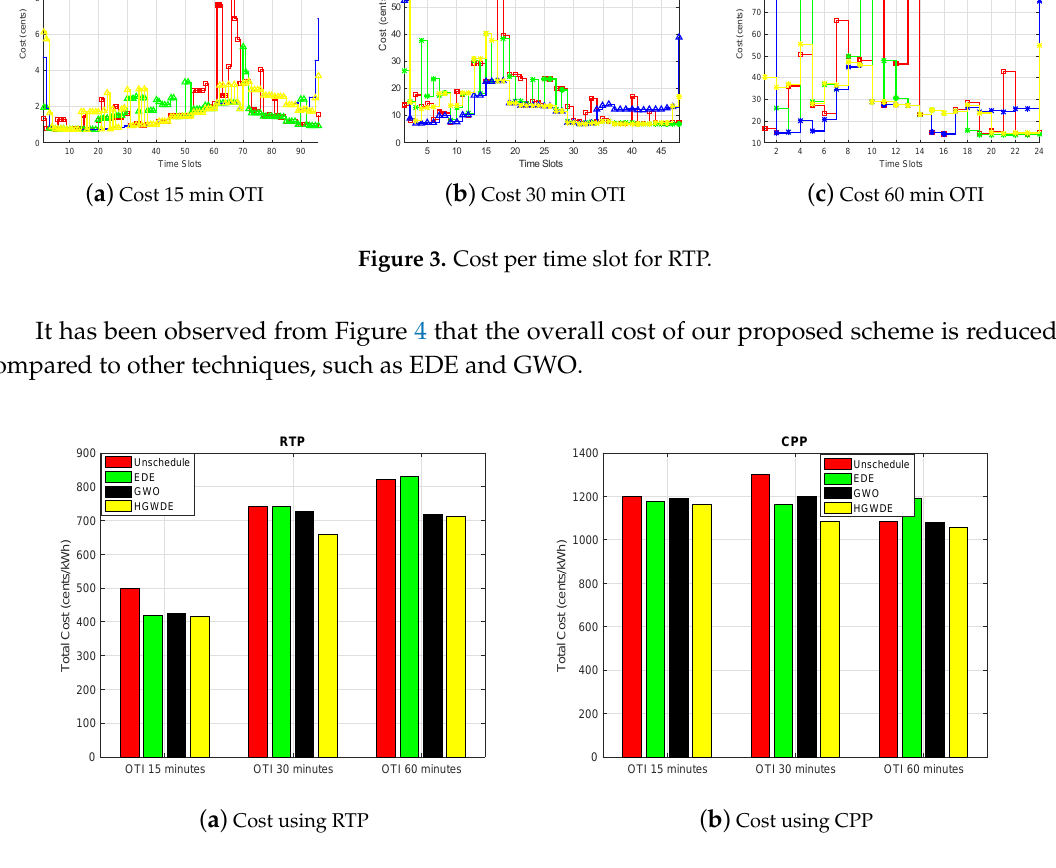
Figure 4. Total cost after scheduling using RTP and